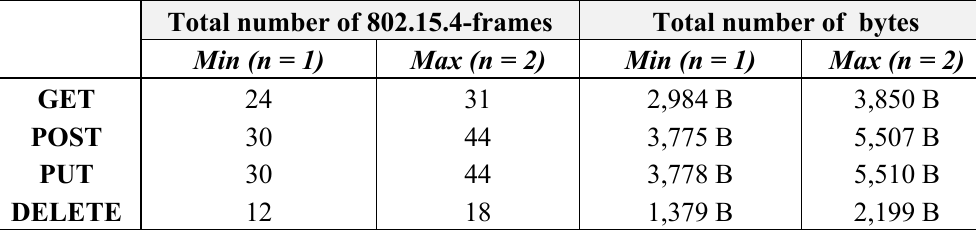
Table 3. Analysis of CoAP on a transaction basis.